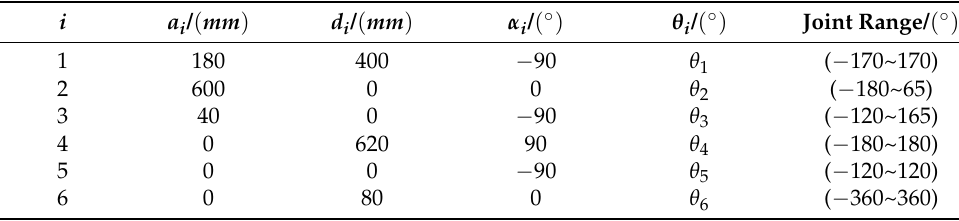
Table 1. Robot linkage and geometric parameters.